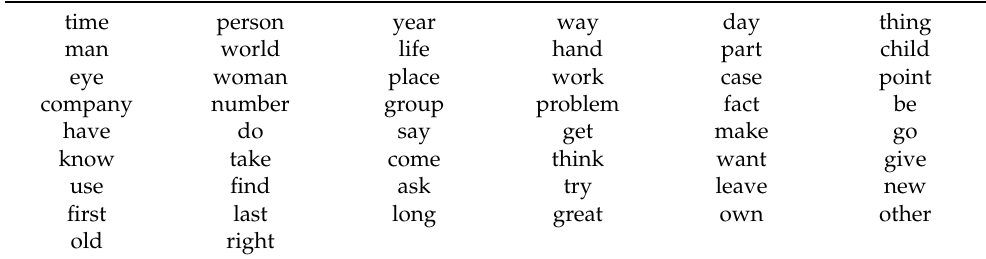
Table 3. Fifty commonly used English words.